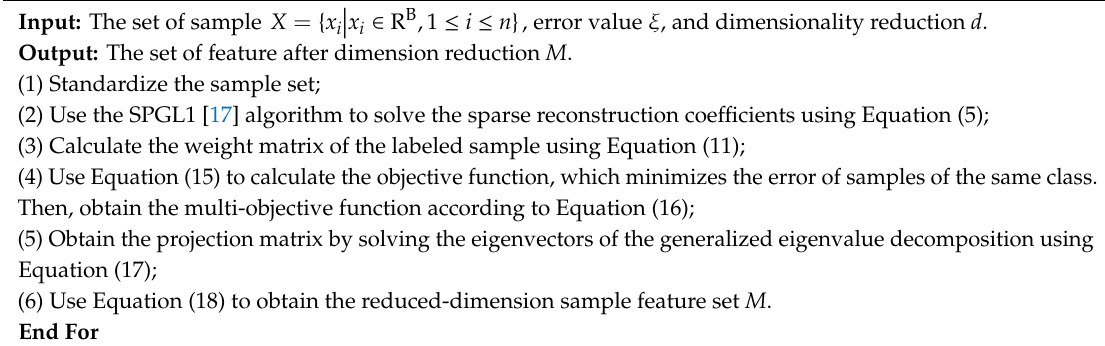
Algorithm 1: Supervised Sparse Embedded Preserving Projection